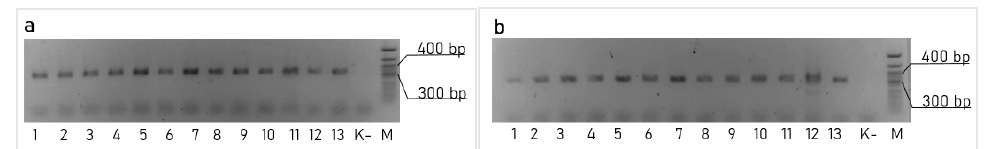
Figure 3. PCR confirmation of the target edition: ( a ) transposition of the 1 kbp insert, performed by the pLcDonor and pLcINT plasmids pair with a crRNA01; ( b ) transposition of the 10 kbp insert performed using the pLcDonor_10 kb and pLcINT plasmids pair with a crRNA01.